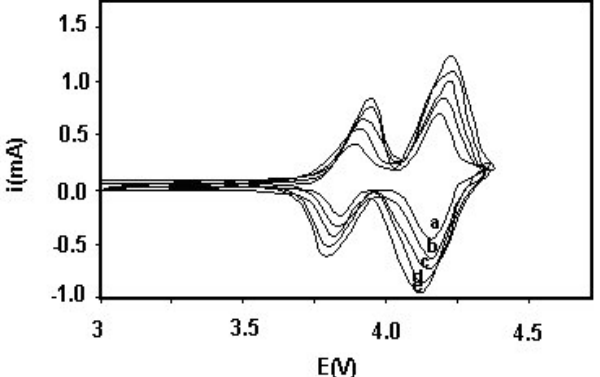
Figure 6. Cyclic voltammetry curve of (a) LiMn 2 O 4 (b) LiNd 0.1 Mn 1.9 O 4 (c) LiNd 0.2 Mn 1.8 O 4 (d) LiNd Mn O and (e) LiNd 0.3 1.7 4